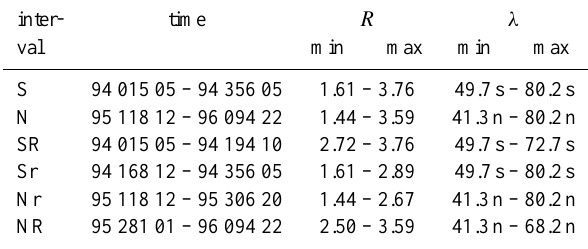
Table 1. The analysed data intervals: start and end times (year, day, hour), minimum and maximum distances ( R , in AU), and latitudes ( λ , in ◦ , with n and s for north and south, respectively).